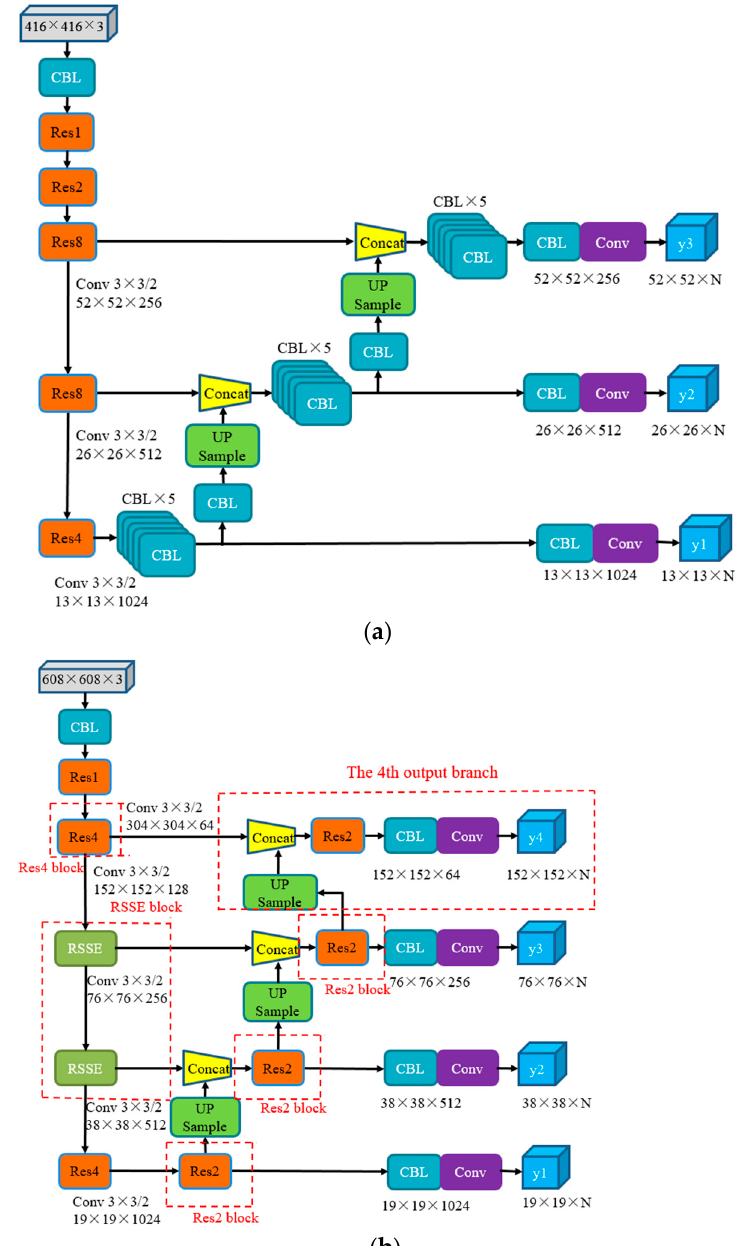
Figure 2. Comparison of network structure improvement. In order to highlight the improved part of the network structure, it is marked with a red box in ( b ). ( a ) The original YOLOv3 network structure; ( b ) The improved RSSE-YOLOv3 network structure.